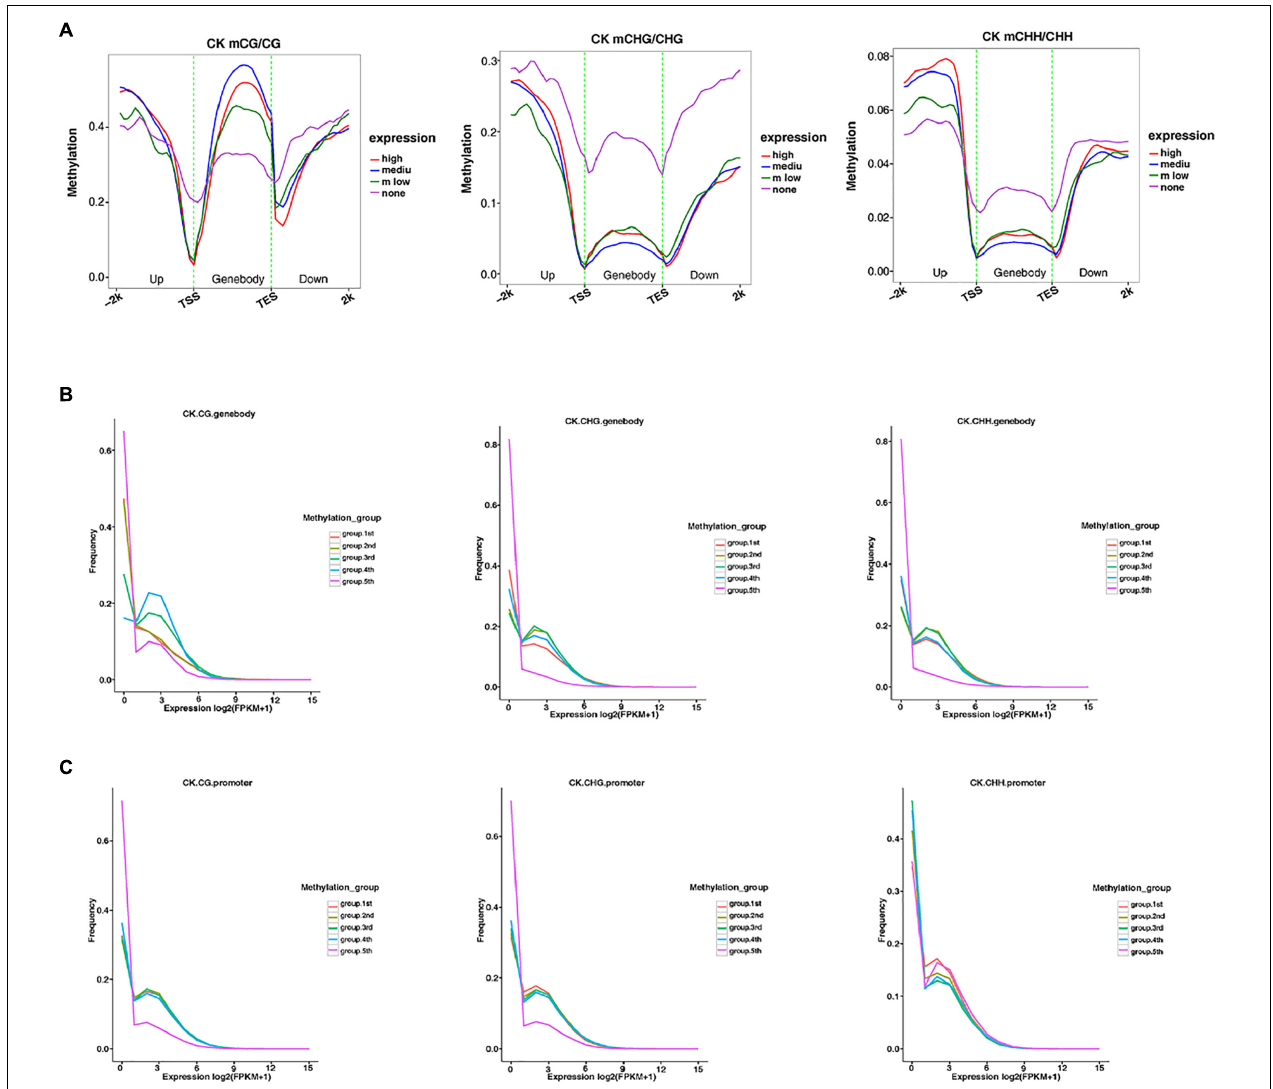
FIGURE 5 | The relationship between methylation among different expression profiles and the overall transcriptome. (A) The distribution of methylation levels of genes under different expression levels in the gene body and its upstream and downstream 2 Kb regions under different sequence contexts (the abscissa represents different regions, and the ordinate represents the methylation level. Different colors represent different expression levels). (B,C) The expression levels of genes under different methylation levels in the gene body and promoter regions under different sequence context. (The abscissa represents the expression level, and the ordinate represents the frequency of the gene at the corresponding expression level. Different colors represent different methylation